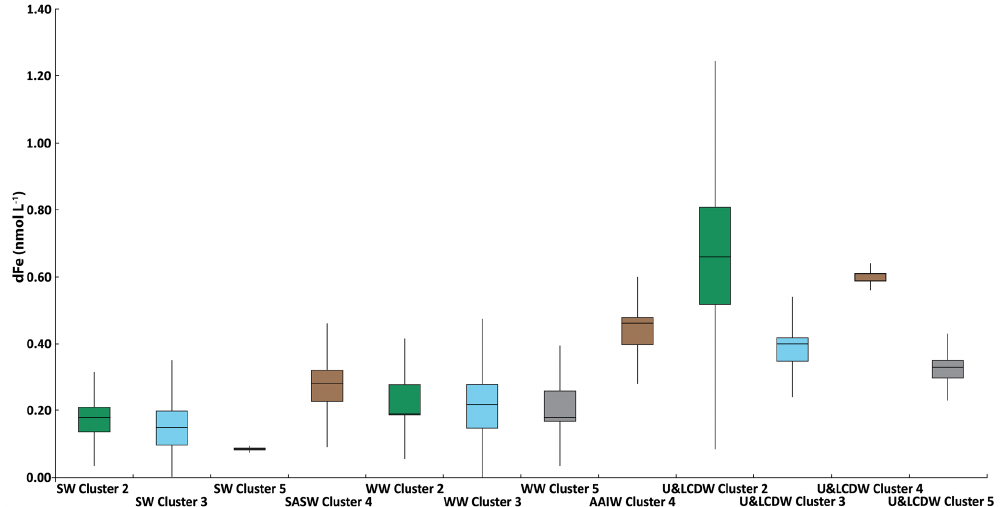
Figure 3. A box plot of the dFe concentrations in each water mass present in clusters 2 to 5: surface waters (SW and SASW), winter waters (WW), Antarctic Intermediate Water (AAIW), and Lower and Upper Circumpolar Deep Water (LCDW and UCDW). Median values are indicated by a horizontal line within the box, the box represents the interquartile range, and the whiskers extend to 5th and 95th percentile values. Data from cluster 1 are not shown to allow a clearer representation of the other clusters.